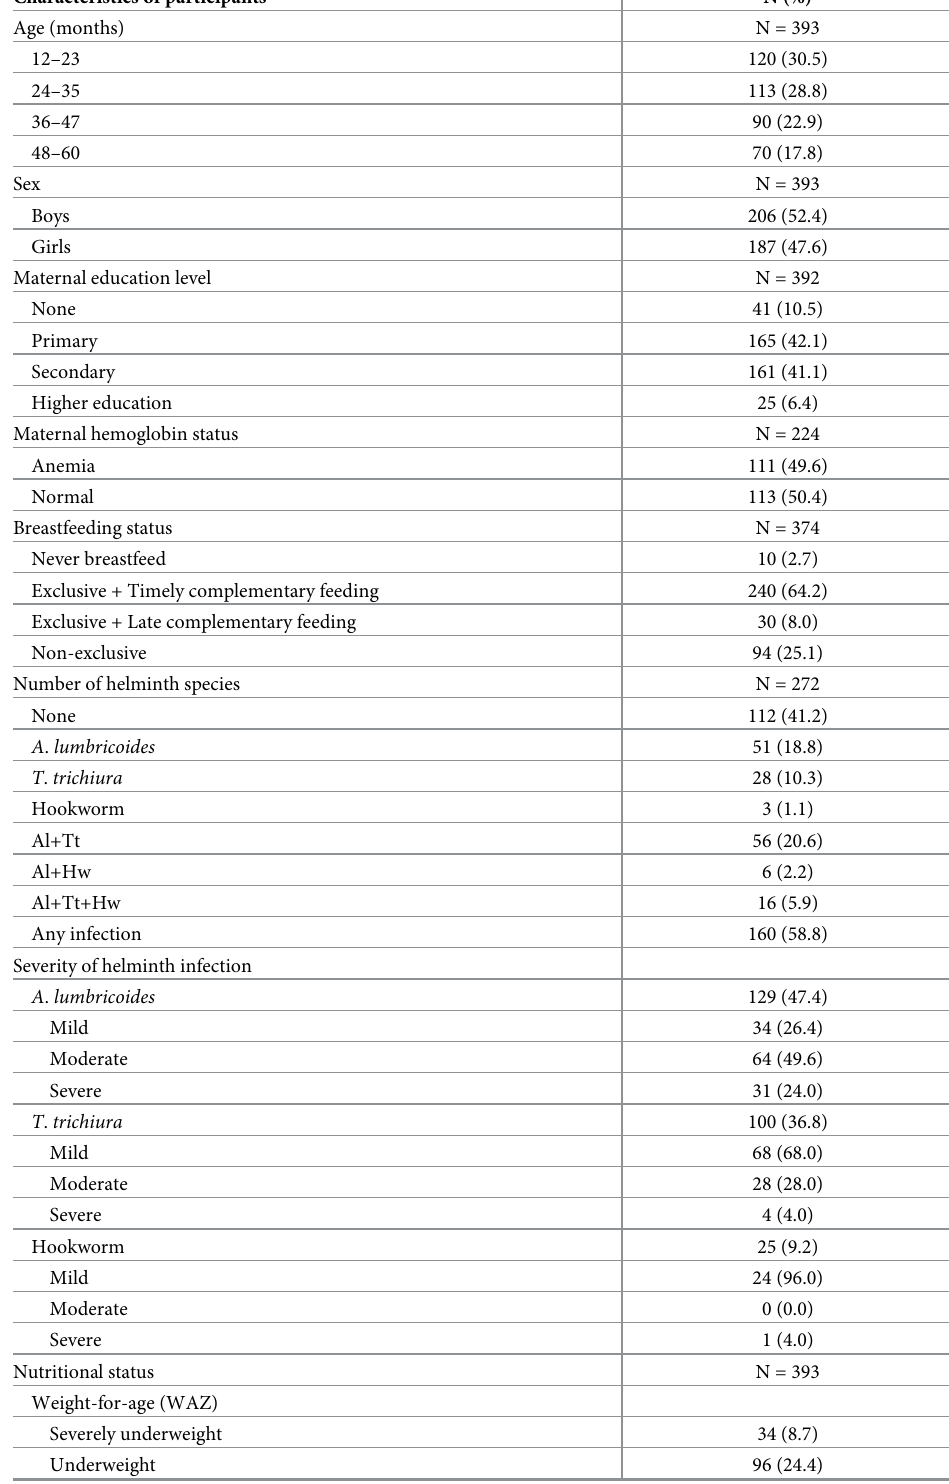
Table 1. Characteristics of enrolled preschool-age children